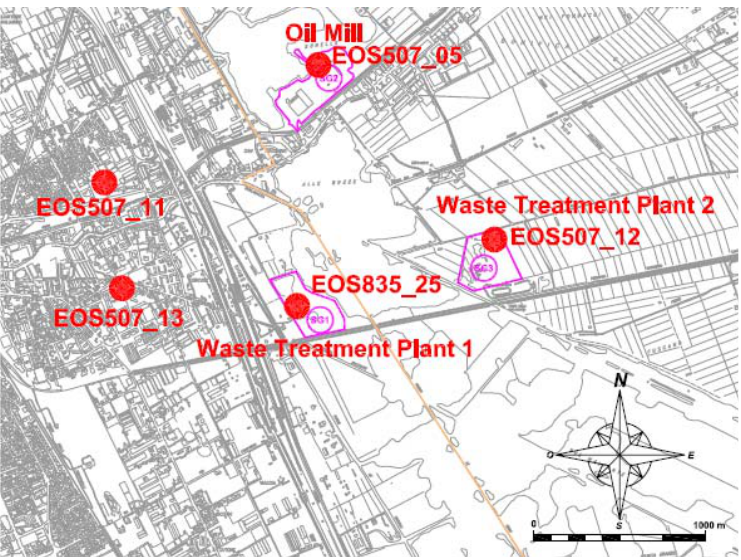
Figure 4. Position of the electronic